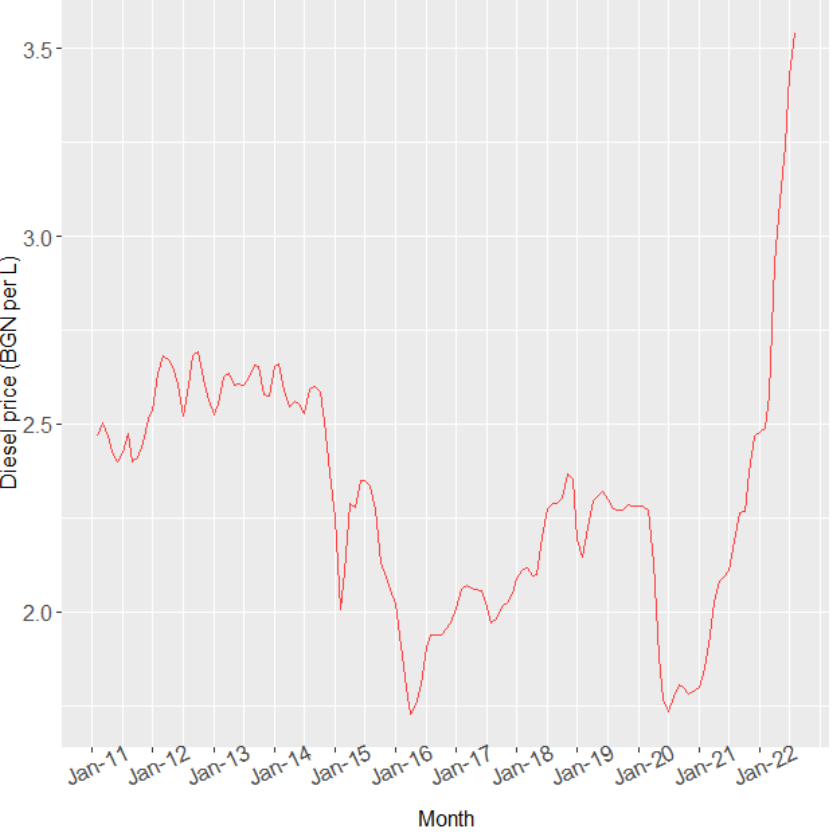
Figure 1. Monthly diesel price from January 2011 to July